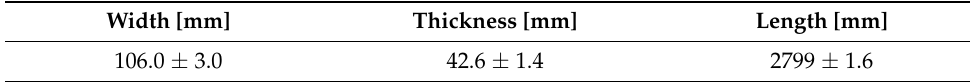
Table 1. Average dimensions of the